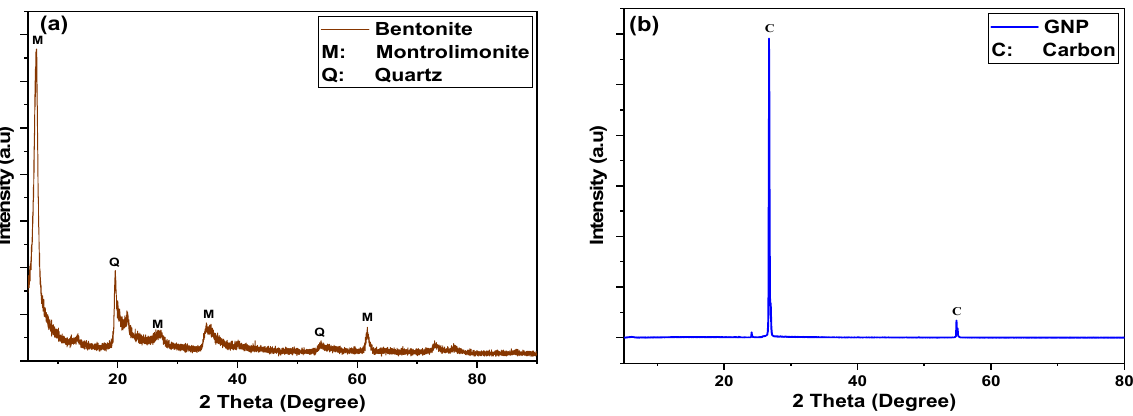
Figure 1. X-ray diffraction (XRD) spectrum of ( a ) bentonite and ( b ) graphene nano platelets (GNP).